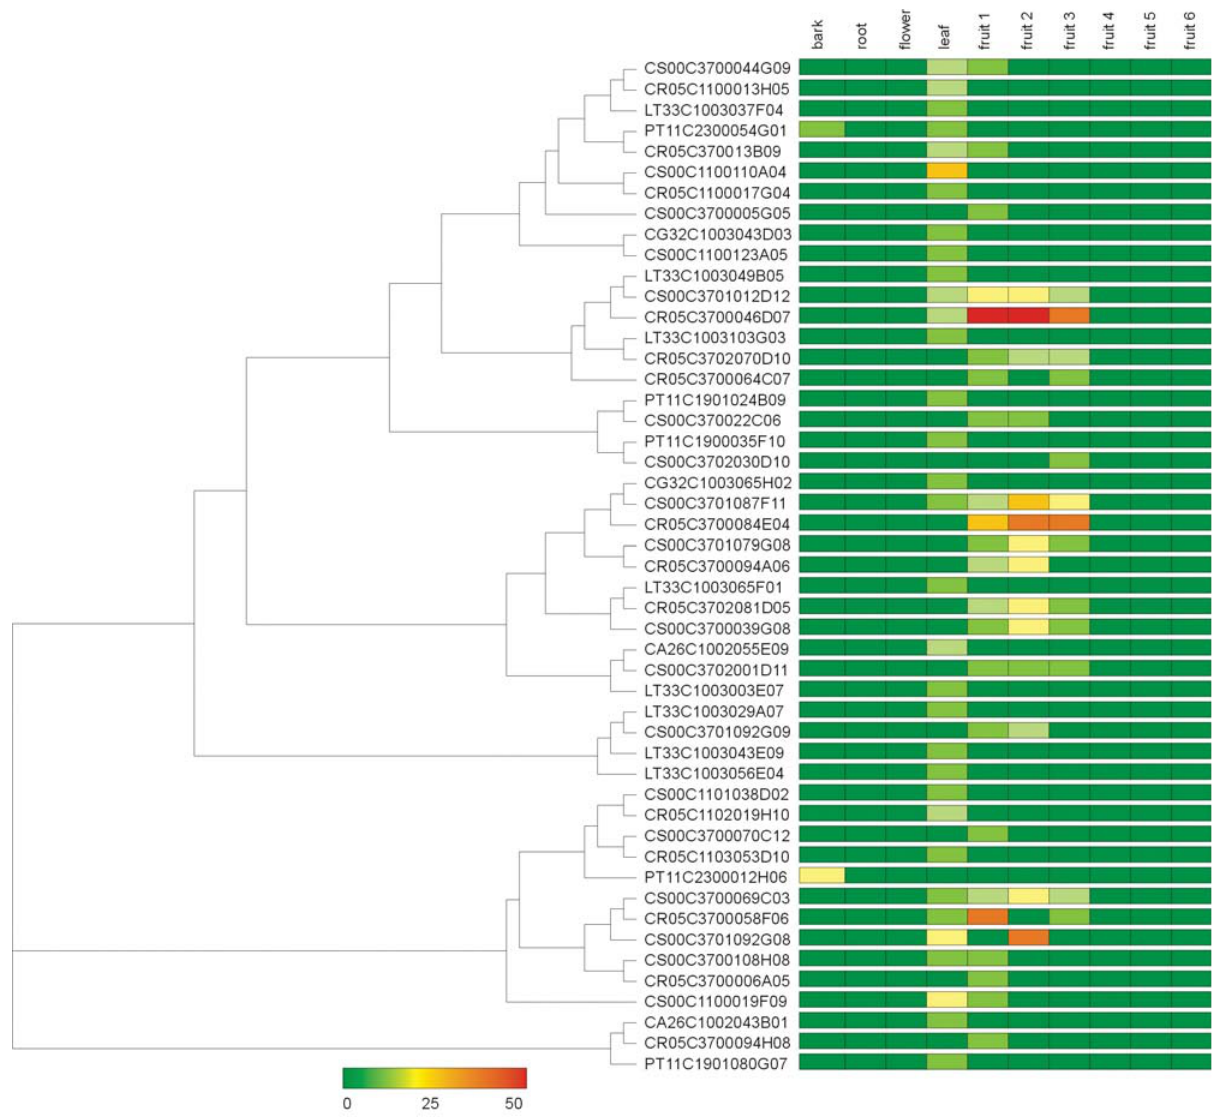
Figure 4 - Expression profiles of the 49 putative Citrus terpene synthase EST clusters in selected cDNA libraries from the CitEST database. Data repre- sent the relative number of reads from a specific library in each EST cluster after normalization. Each EST cluster is represented by a single row, and each library is represented by a simple column. The cladogram on the left represents the relatedness of all Citrus sequences and was built according to their rel- ative genetic distances (Saitou and Nei, 1987). For consistency of each clade, use other figures for